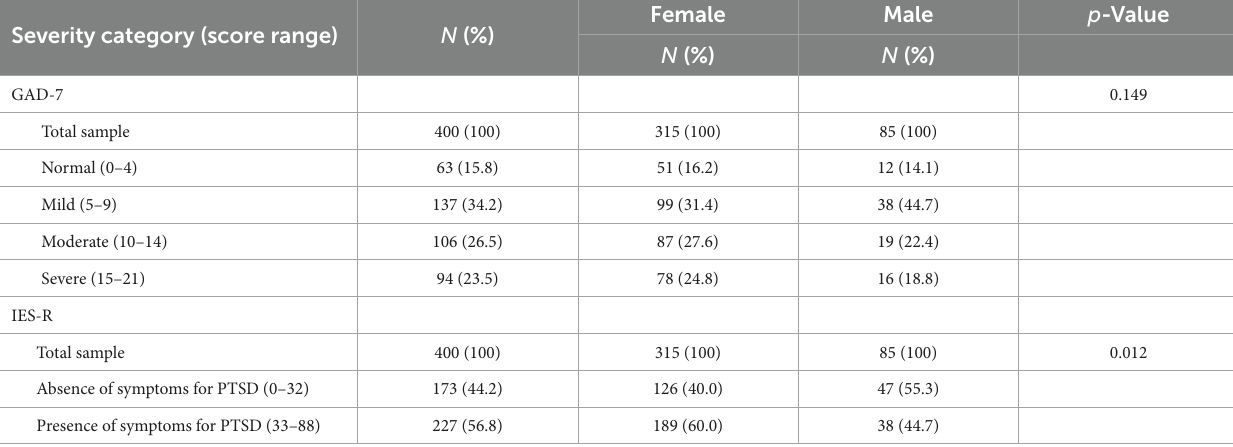
TABLE 3 Distribution of generalized anxiety disorder and post-traumatic stress disorder scores in the study sample and by gender.